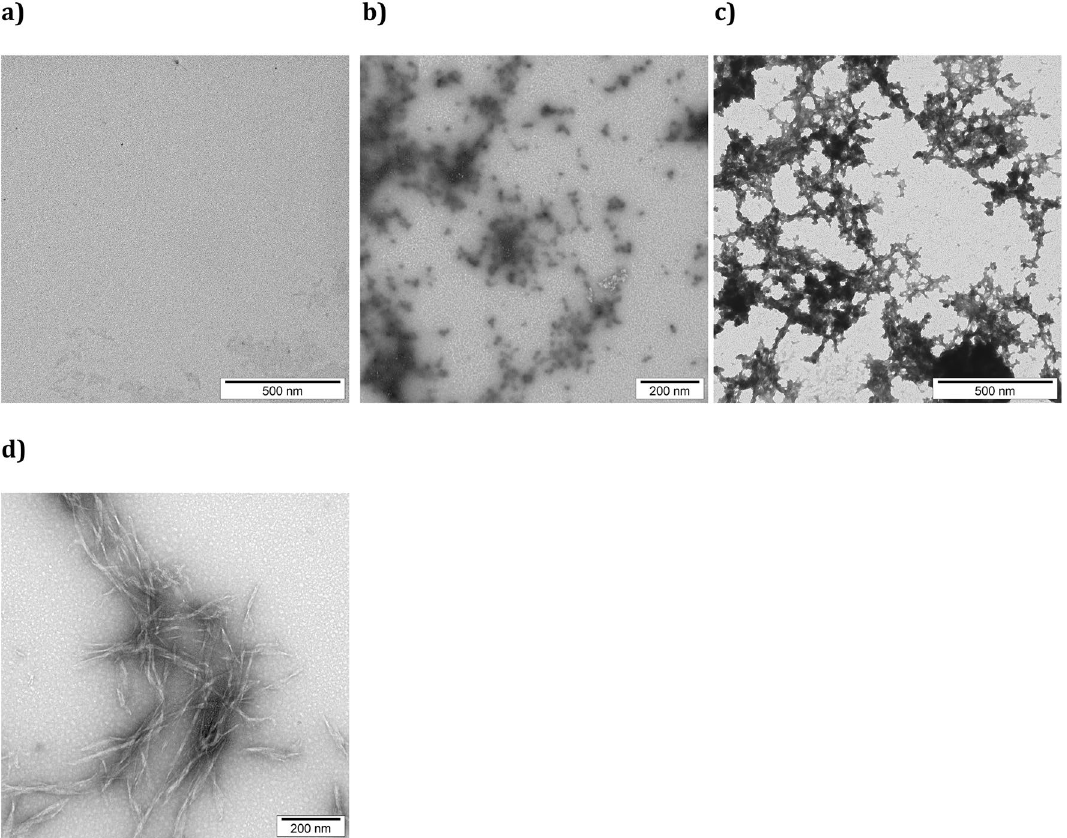
Figure 3. TEM images of ERα17p amyloid fibrils. ERα17p is incubated over 48 h at the concentration of 100 μM at the pH values of ( a ) 3.4 (glycine HCl 0.2 M in water), ( b ) and ( c ) 7.4 (0.2 M KH 2 PO 4 /0.2 M K 2 HPO 4 in water) and ( d ) 9.1 (0.2 M glycine NaOH in